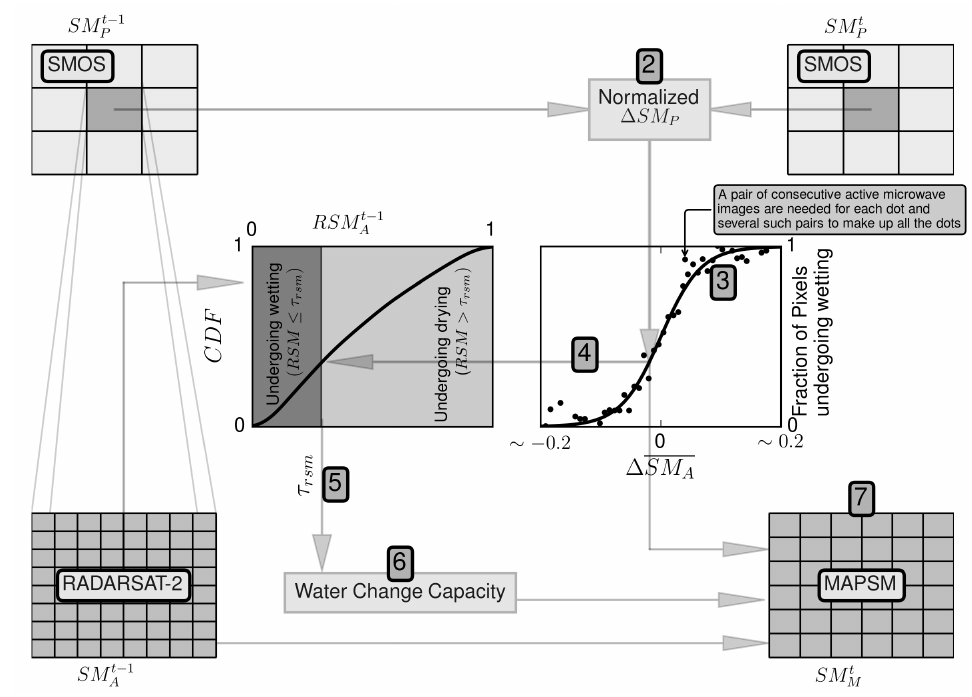
Figure 7. Schematic of the MAPSM algorithm. Subscript A and P are for active and passive microwave, respectively. Numerals represent the step described in the